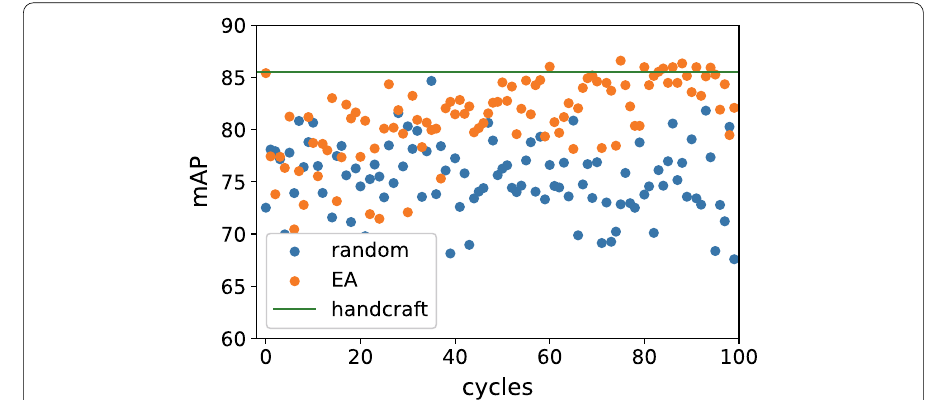
Fig. 8 The comparison between the proposed searching scheme, the random searching, and the handcrafted detector. The orange points are the detectors searched by the proposed algorithm in every evolution cycle. The green line is the best handcrafted model’s performance. Blue points are random